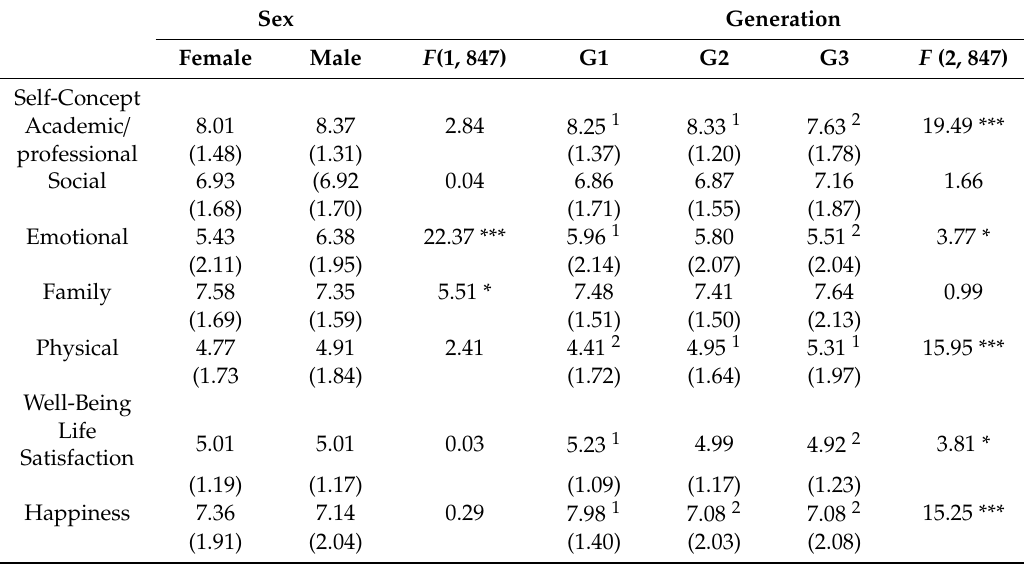
Table 5. Means and (standard deviations) of generation and sex, and main univariate F values for psychosocial adjustment (self-concept and well-being).